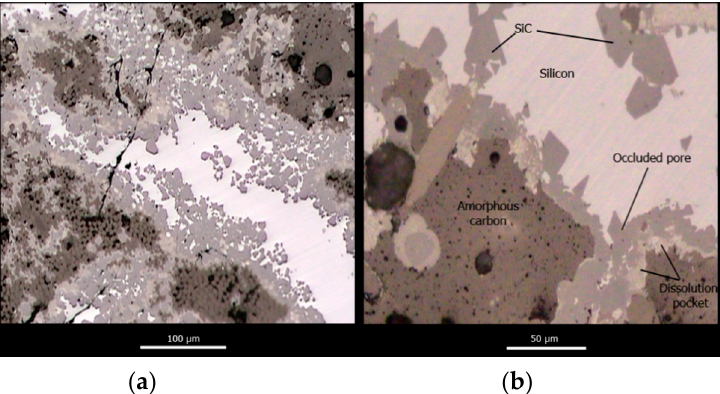
Figure 12. Pore reduction and pore closure phenomena in C f / SiC composite materials during reactive infiltration ( a ) and a zoomed in view of a totally occluded pore ( b ).